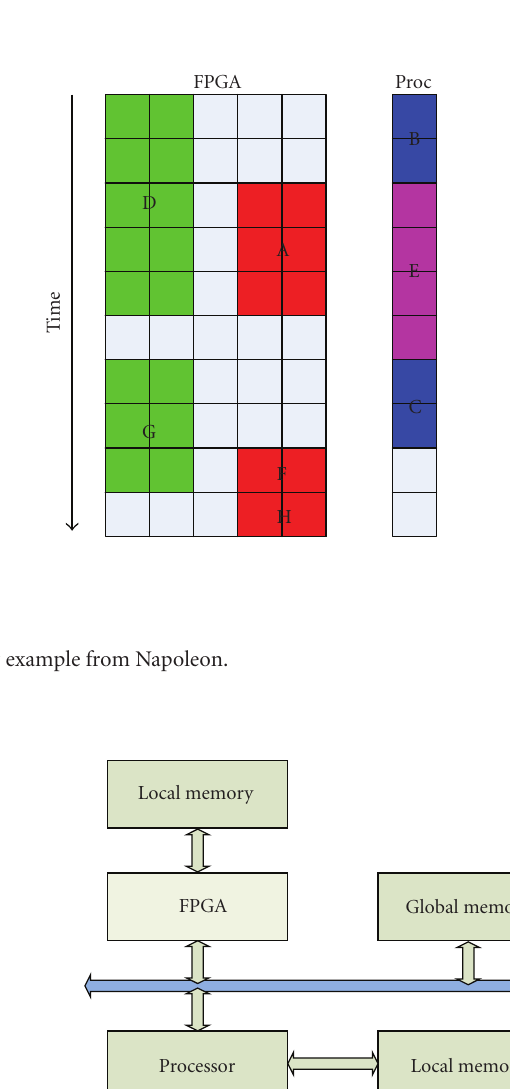
heterogeneity in the conformation of the columns of the FPGA. This is a model for the problem considered in this work, but module reuse is never